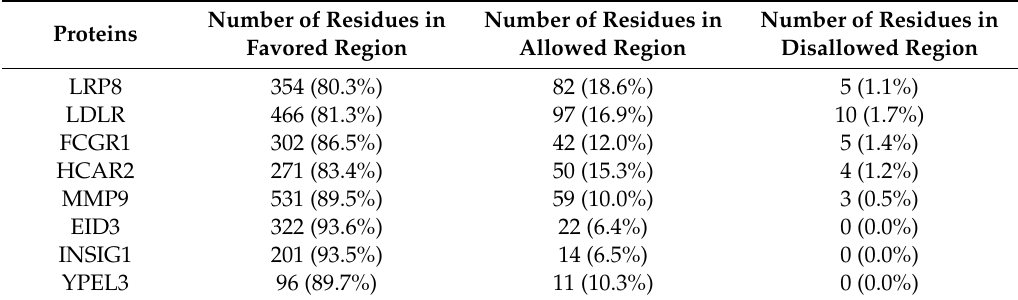
Table 4. Ramachandran plot